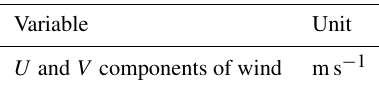
Figure 5. Bar graph showing the 10m wind speed error distribu- tions for the COSMO-CLM (in blue) and WRF (in red) models, derived through comparison with available hourly station observa- tions (3448209 in